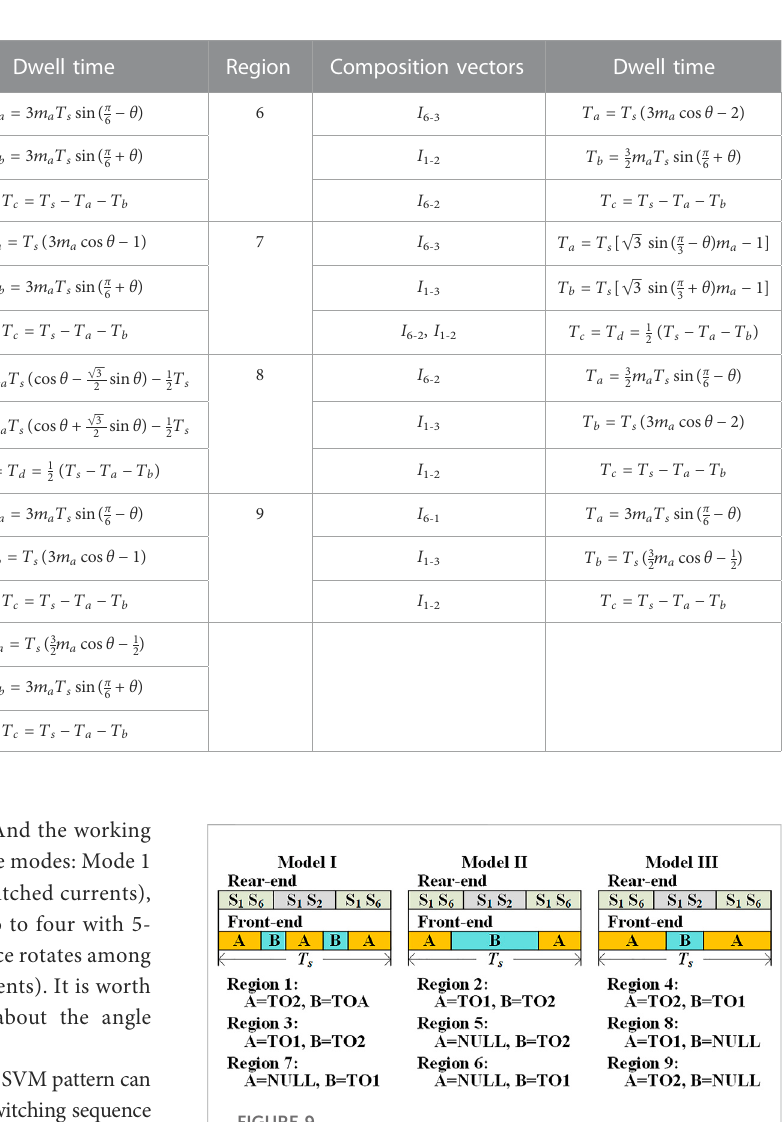
FIGURE 9 The models of switching sequences (in Sector